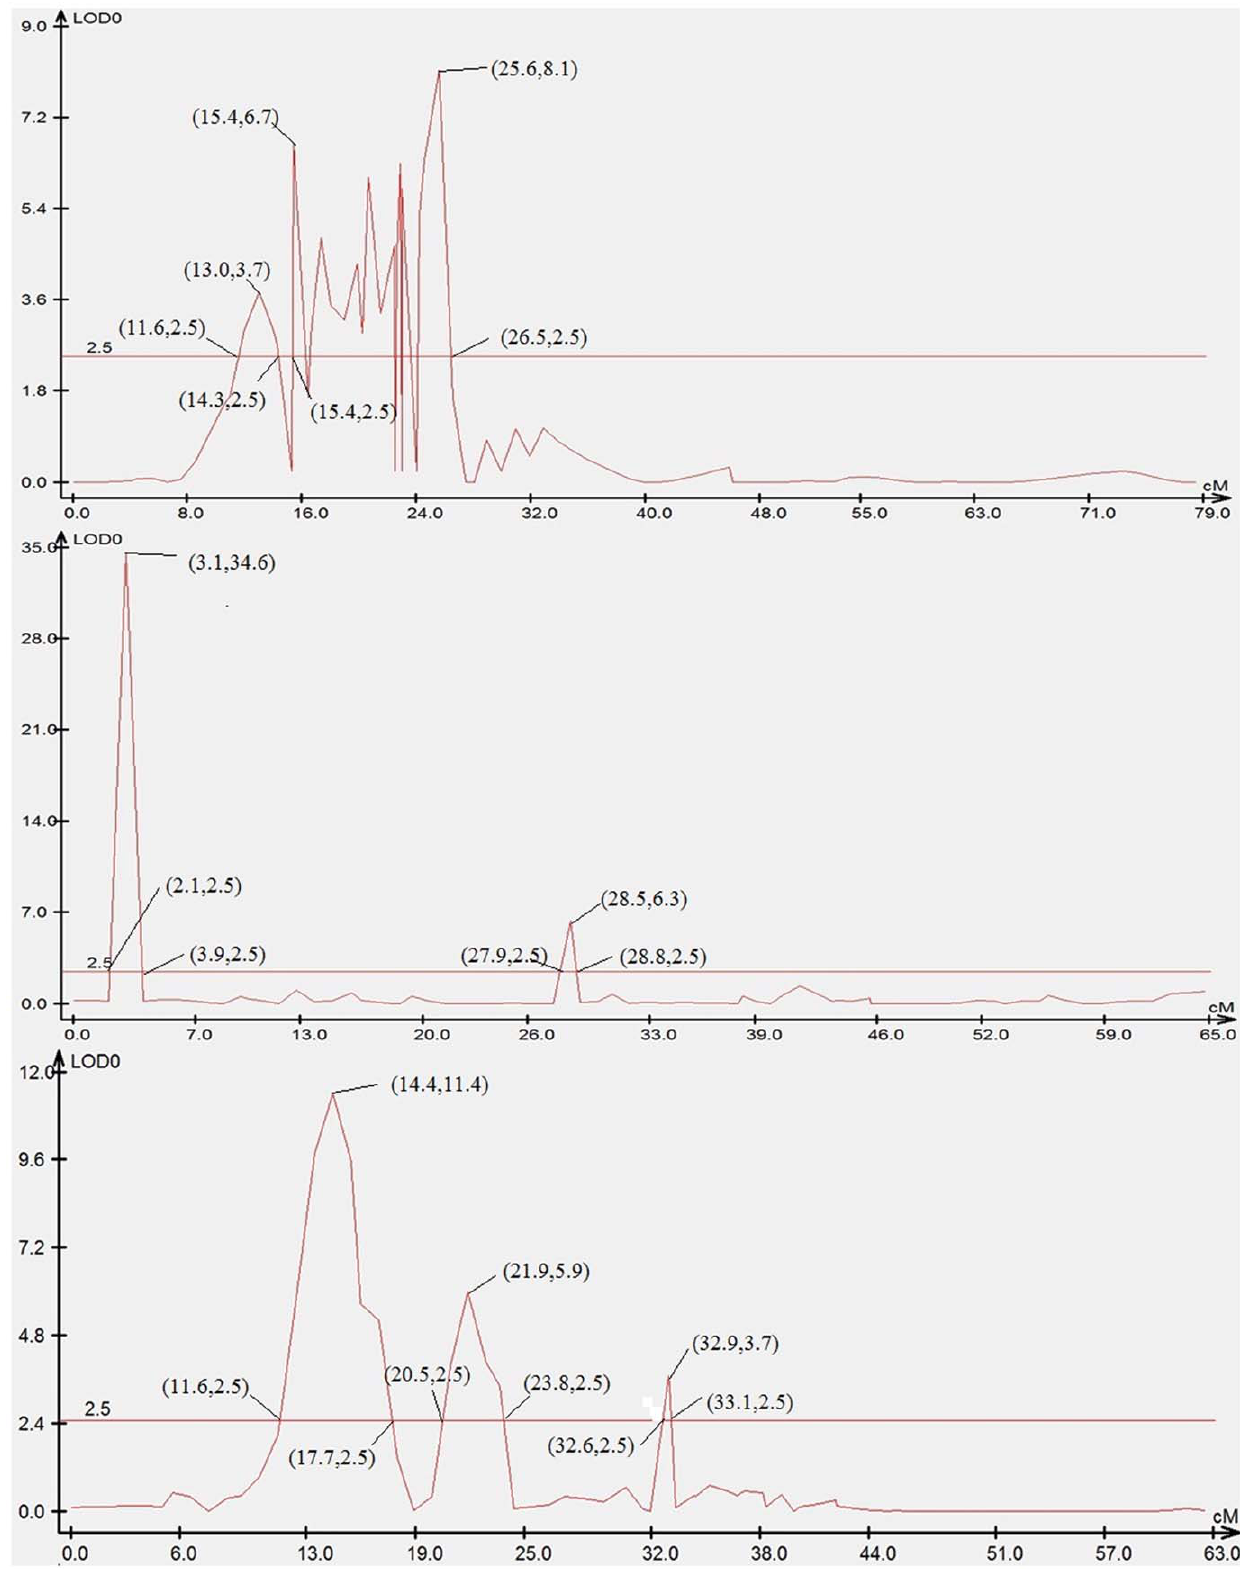
Figure 6. LOD curve graph of seven sex-related loci. Abscissa indicates the relative position on the linkage groups, vertical coordinates indicates the value of LOD; the figure in ‘‘()’’ represents (position, value of LOD).